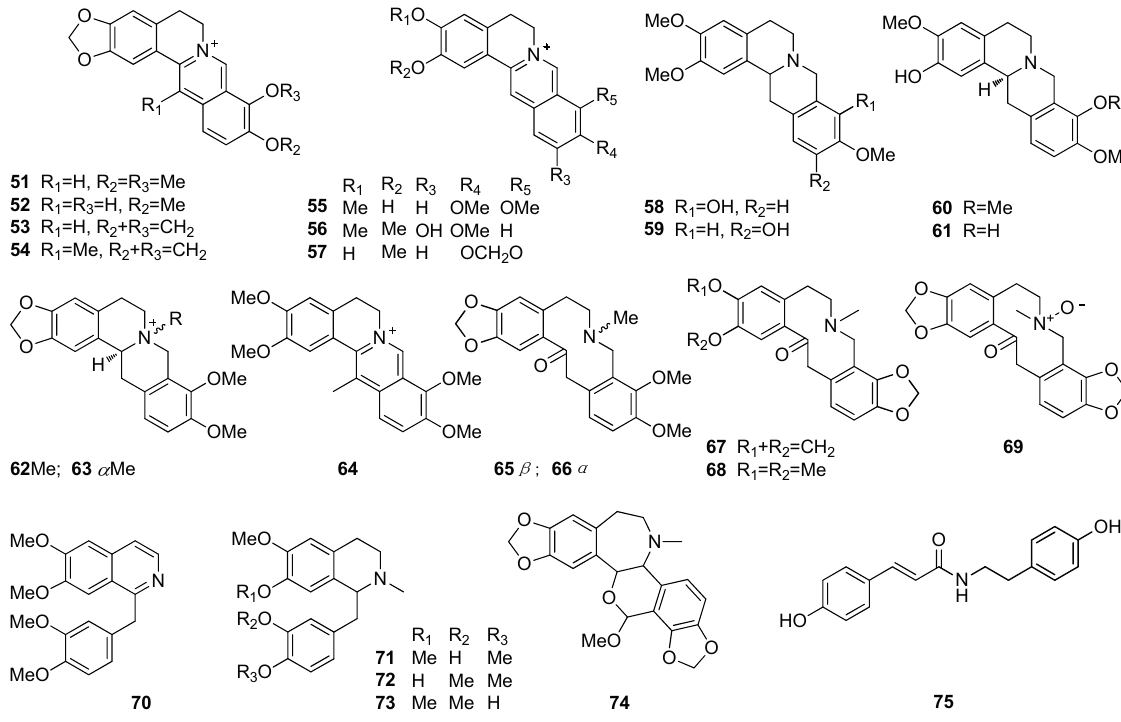
Figure 2. Structures of compounds 51 – 75 from